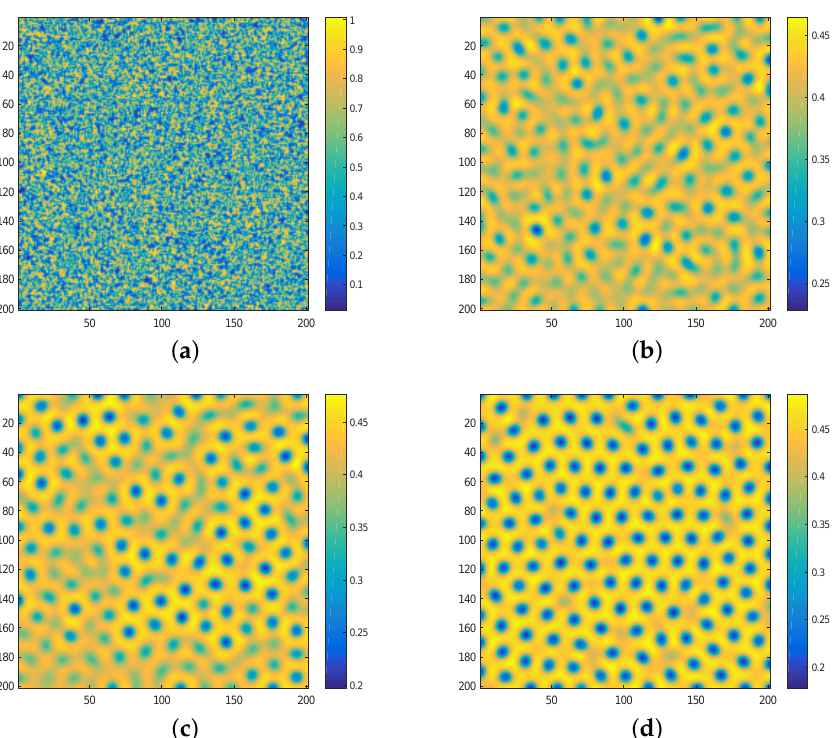
Figure 2. The process of formation of the prey patterns at c = 0.55, the other parameters are fixed as in (23). Times: ( a ) t = 0, ( b ) t = 150, ( c ) t = 300, and ( d ) t = 1000.